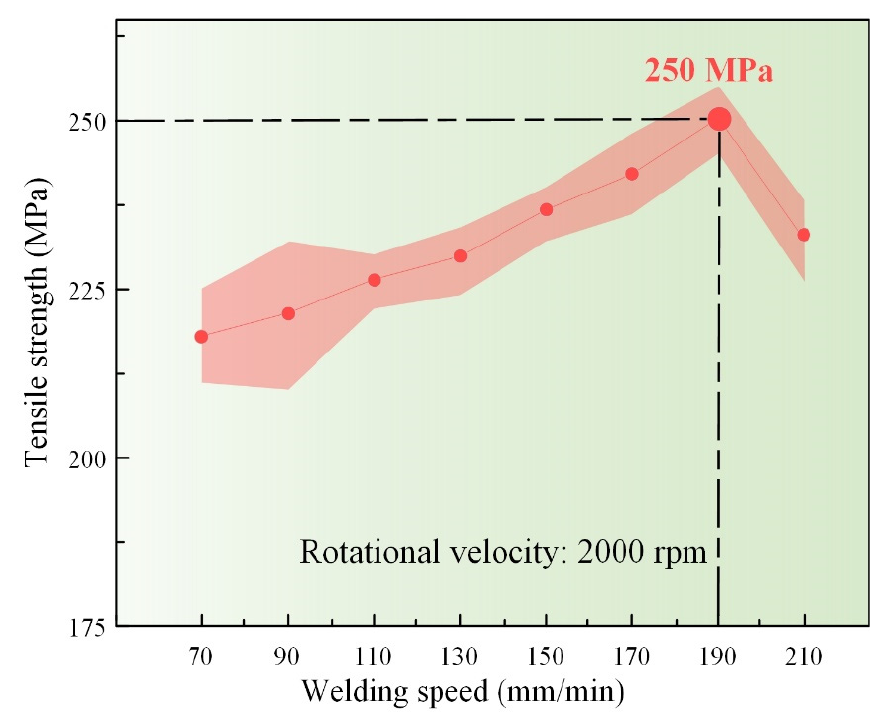
Figure 9. Tensile strength of joints at different welding speeds.